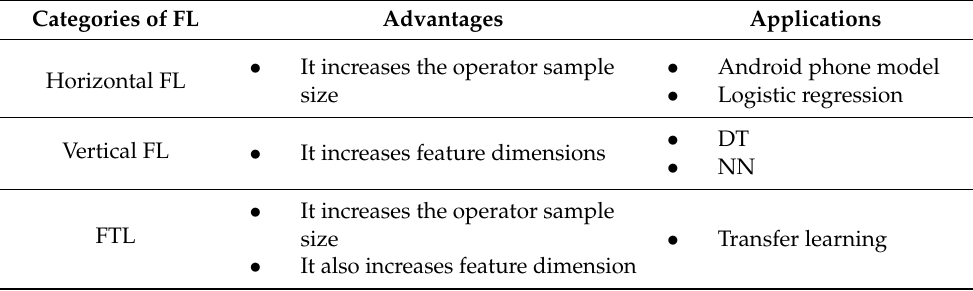
Table 6. Summary of FL categorization.